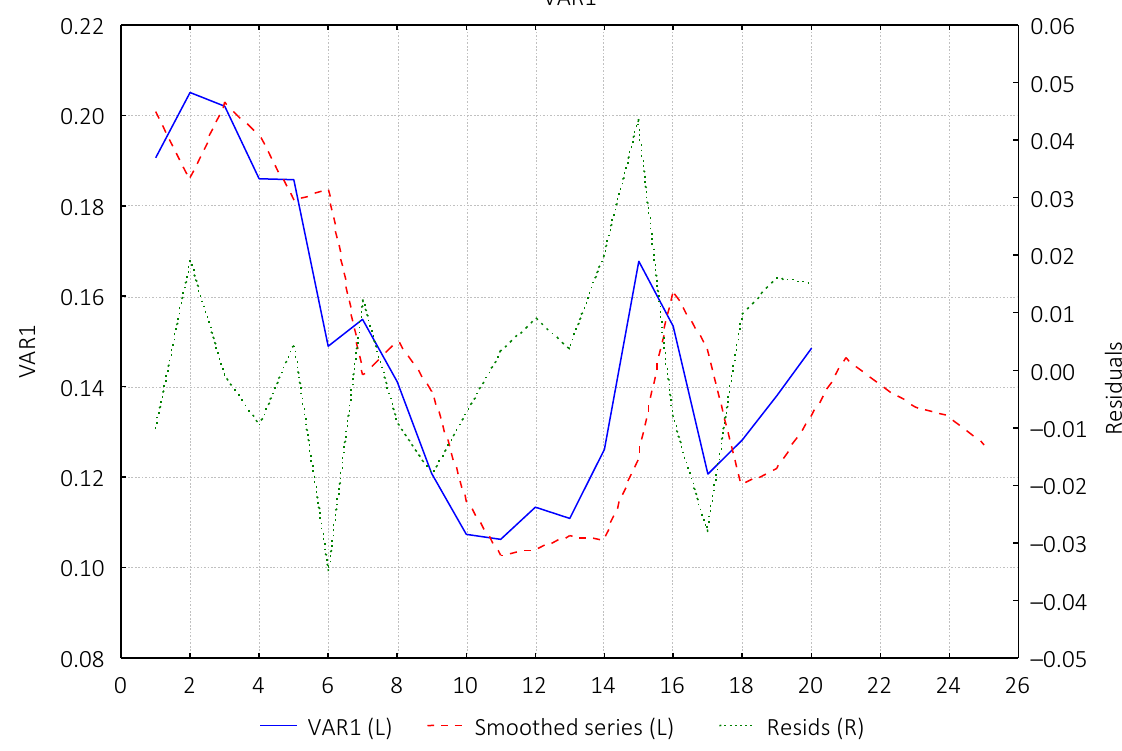
Figure 5. Exponential smoothing of the financial security forecast